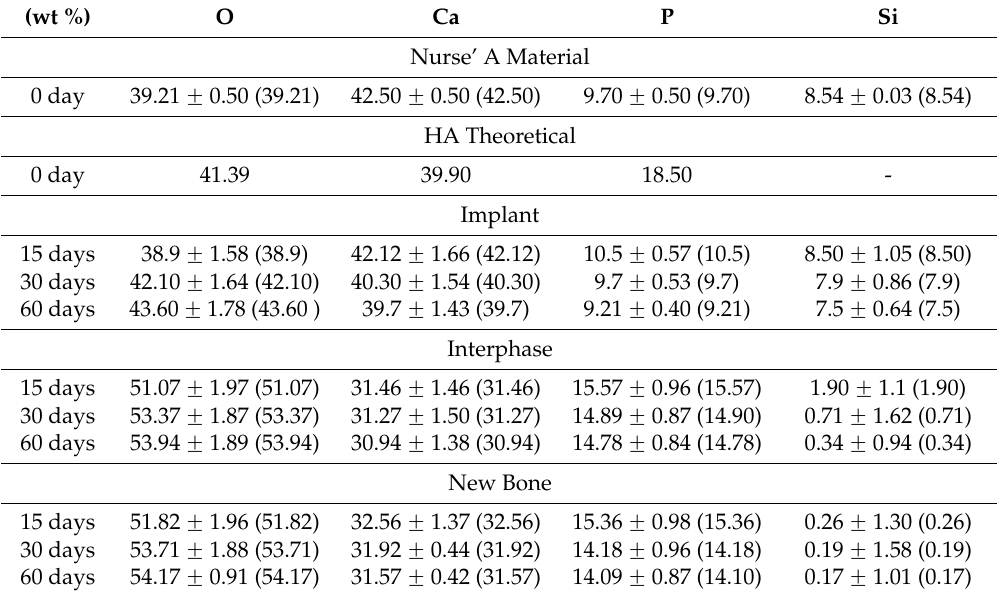
for comparative